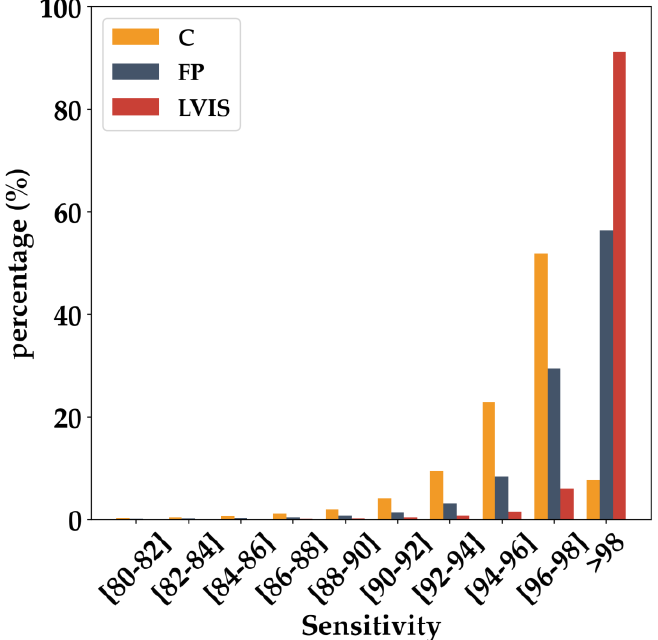
Figure 6. Distribution of GEDI’s coverage (C) and full-power (FP) shots, as well as those of LVIS, by footprint sensitivity.